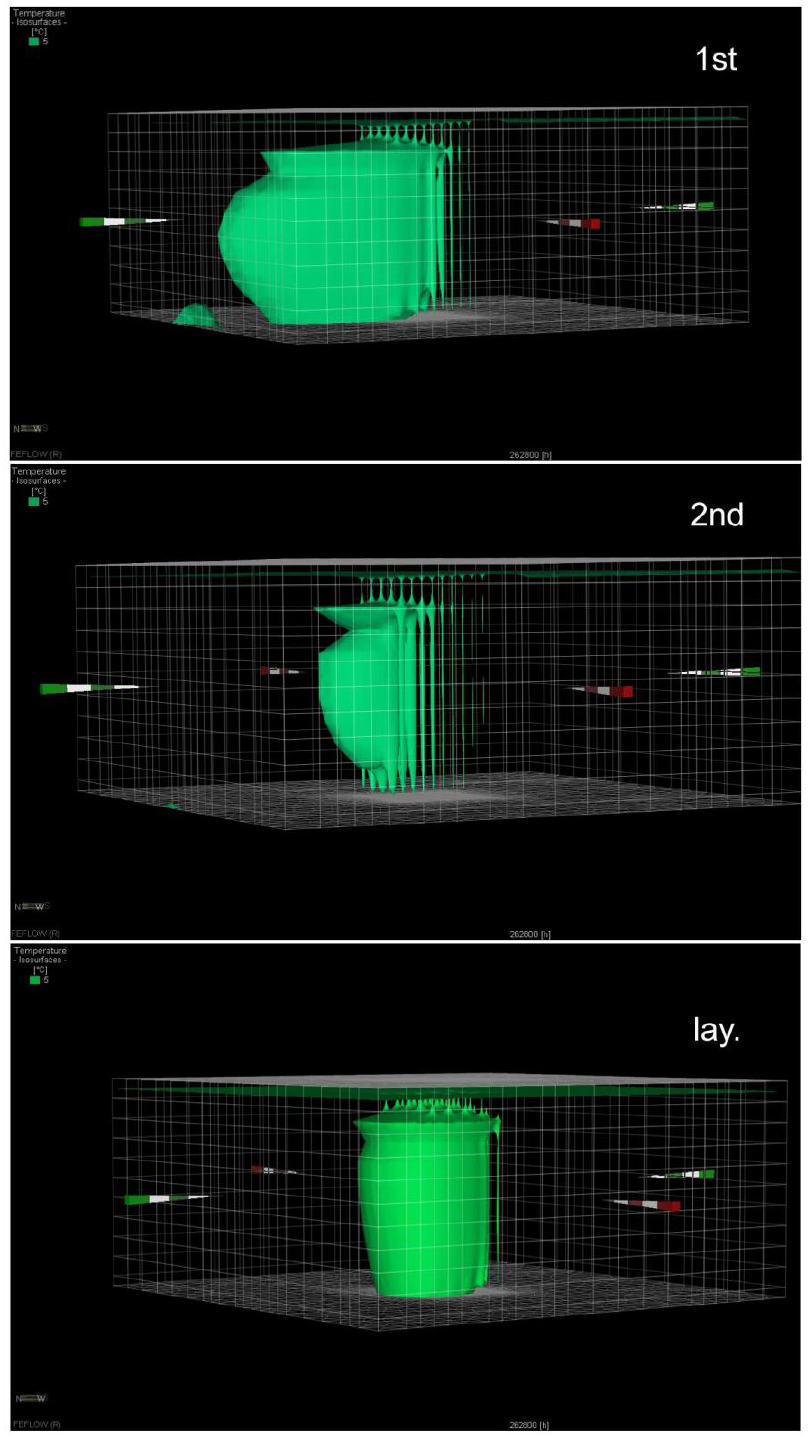
Figure 17. Cold plumes in 3D models for 3 di ff erent scenarios (1st scenario, 2nd scenario and layered model (3rd scenario)) after 30 years of system